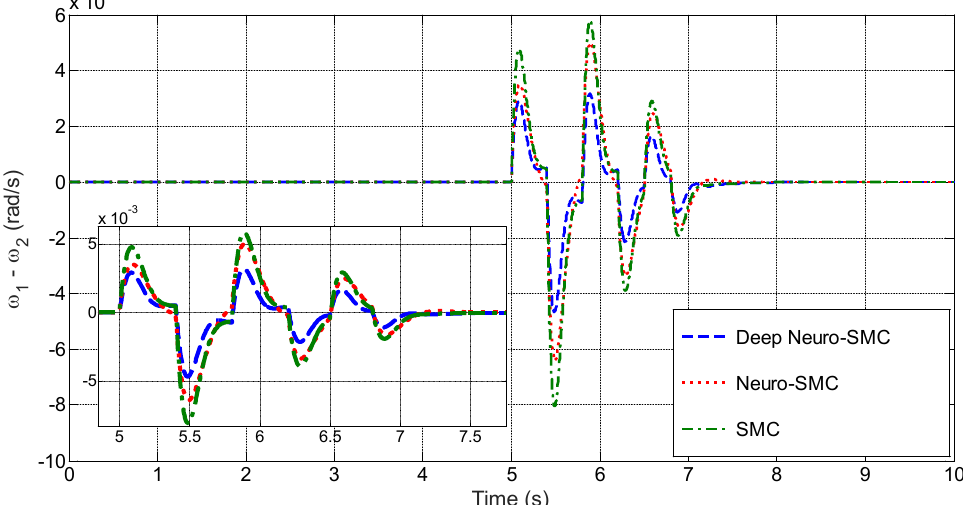
Figure 7. Comparison of generator speed changes (Second case).